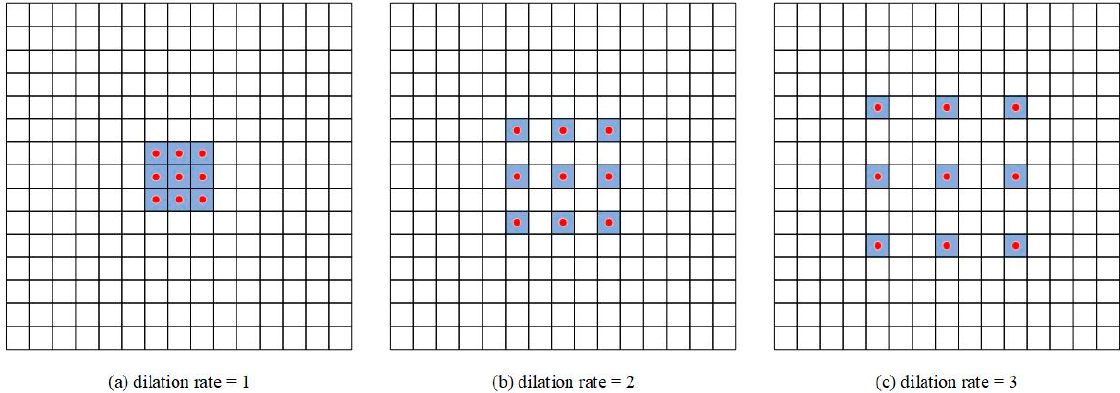
Figure 7. An illustration of dilated convolution. The positions of red dot are the actual positions that accomplish convolution operation with kernels. ( a ) A 3 × 3 convolution kernel with dilation rate 1. ( b ) A 3 × 3 convolution kernel with dilation rate 2. ( c ) A 3 × 3 convolution kernel with dilation rate 3.